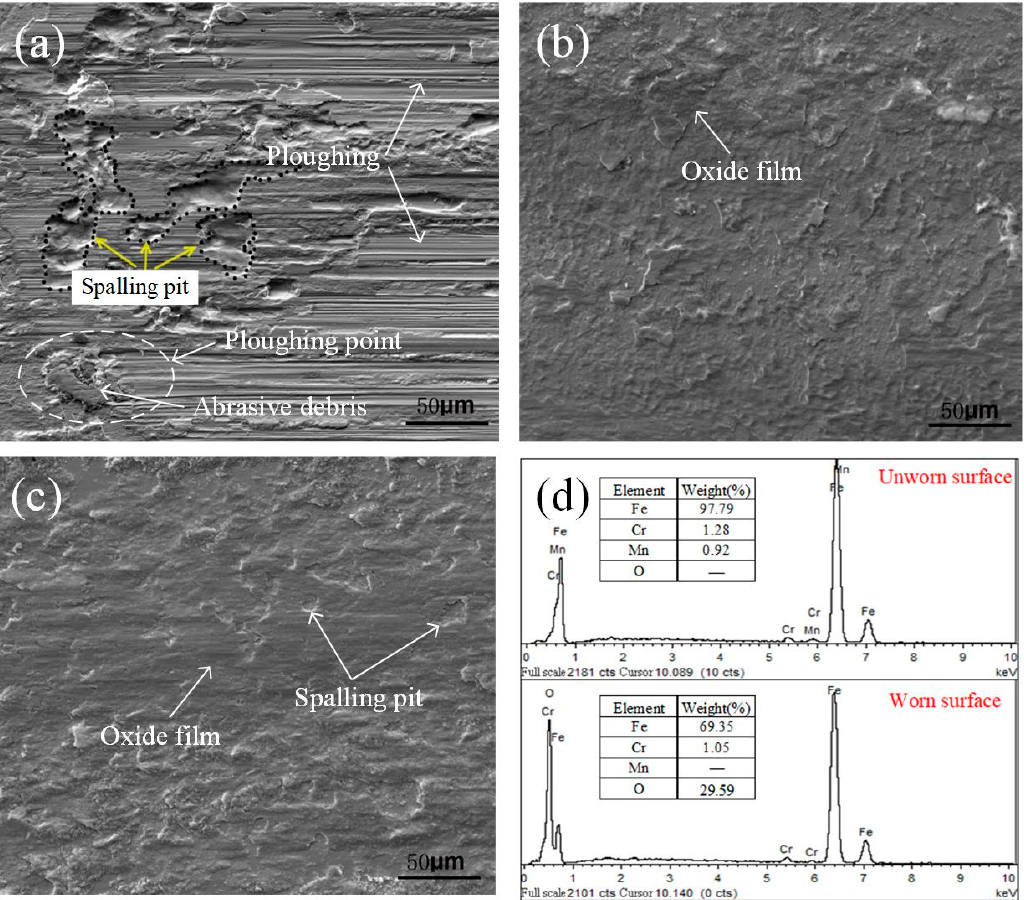
Figure 8. The surface worn SEM micrographs of specimen under different material state: ( a ) virgin state, ( b ) quenched state, ( c ) carburized state; and ( d ) EDS results of carburized specimen.